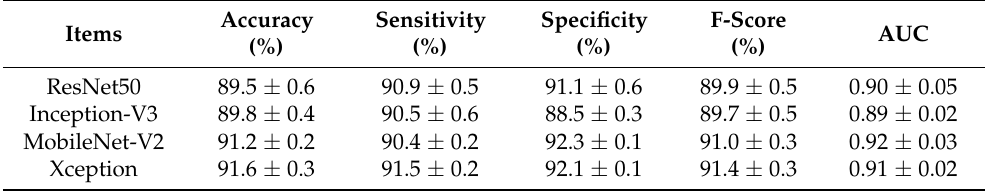
Table 6. Ablation study on CNN